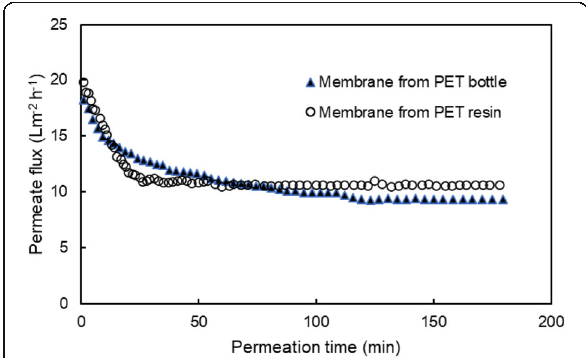
Fig. 6 Comparison of the permeate flux of the membrane prepared from PET bottle and that from PET resin with PEG 400 as the additive